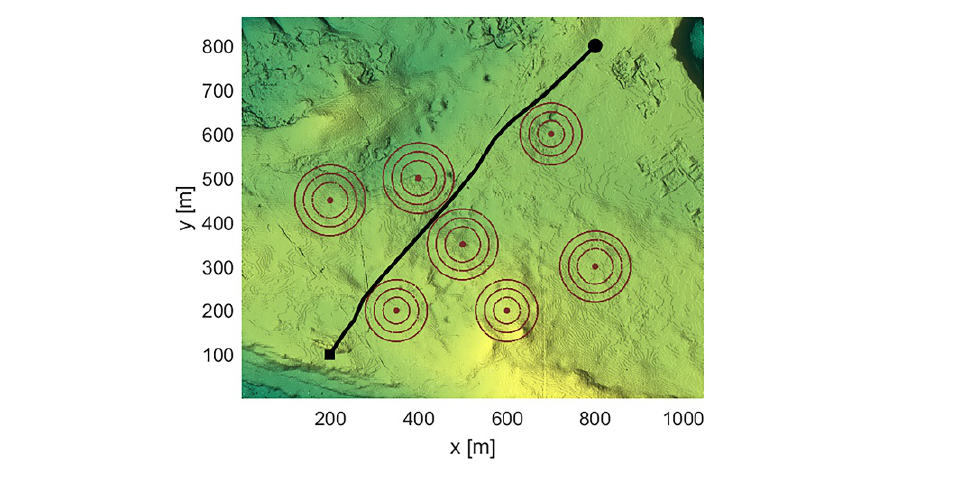
Figure 22. The top view of the path generated by the ninth group of data for the IC-VAINDIWPSO algorithm.